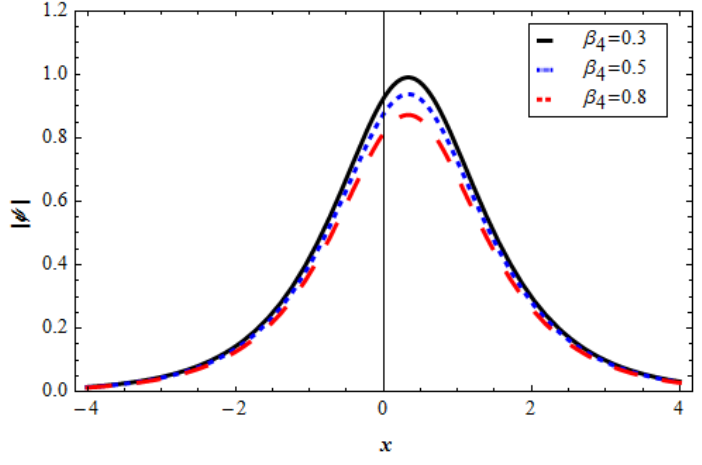
Figure 20. Change of solution (14) with z , t , β 4 for c = 0.5, v = 0.7, β 1 = 0.1, β 2 = 1, β 3 =